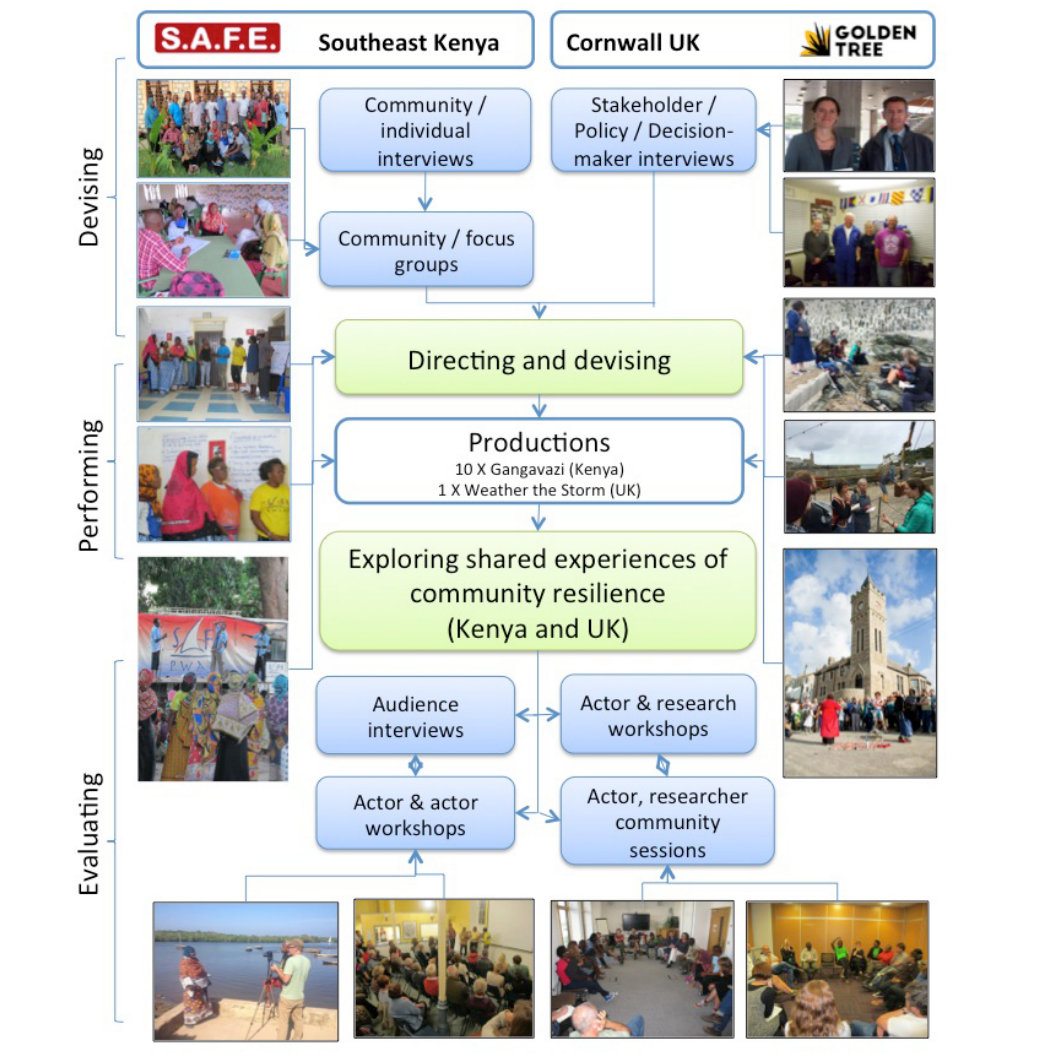
Fig. 1. Timeline and processes involved in devising, performing, and evaluating the theatre